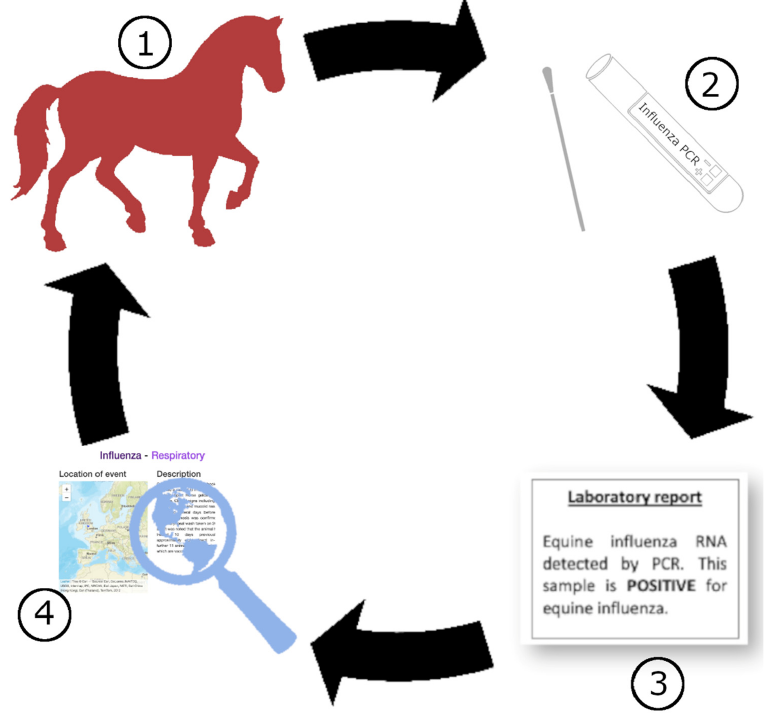
Figure 3. Equine influenza virus surveillance pathway for laboratory confirmed infection. 1. Infec- tious horse noted to be sick by equine keeper and veterinary surgeon contacted 2. Veterinary surgeon suspects infectious process, takes samples during infectious phase, and requests equine influenza agent detection testing such as polymerase chain reaction (PCR) 3. Laboratory correctly iden- tifies equine influenza, and result is reported through a surveillance network 4. Surveillance net- work shares epidemiological data and analyzes viral isolate to determine influenza strain. Monitoring isolates during the seasonal human influenza period is essential to ensure that strain inclusion in vaccines is optimized. So called “immune-escape” variants as a result of antigenic drift may occur during a single epidemic, and research demonstrates that monitoring can be optimized if applied in the latter part of the human influenza sea- son [153]. Surveillance in both species has similar challenges to overcome, and alternative strategies to diagnosing cases through laboratory testing include bioaerosol surveillance, which has been applied in both agricultural and human clinical settings for research pur- poses, and its benefits include that it is low-cost, non-invasive, and samples are more eas- ily obtainable [154,155]. The first accurate report of a human pandemic was in 1580, and numerous reports of pandemics, with spread across the world, have been reported since. Most notable was the 1918 “Spanish flu” [156], the Asian pandemic of 1957 [157] and “Swine flu” in 2009 [47]. Countries with no confirmed outbreaks of EIV are New Zealand and Iceland, although other countries such as Australia and Japan have eradicated EIV. Notable epidemics af- fecting equids include “The Great Epizootic of 1872” in the United States, resulting in ex- tensive disruption to human transportation and essential services [158], and more recently in 2007, EIV demonstrated its plague-like abilities spreading across the highly susceptible Australian equine population with over 10,000 infected [108]. Notable strain changes have occurred including in Hong Kong in 1992, when it was first identified that there were two lineages of H3N8 (American and Eurasian) and in the UK in 2003 when Florida Clade 2